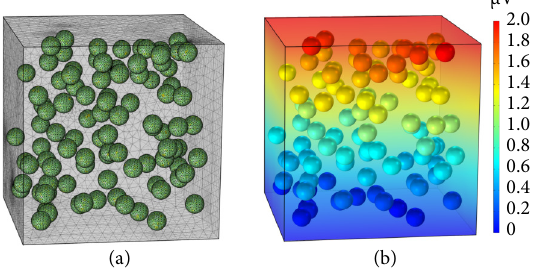
Fig. 3 The FEM to predict the relative permittivity of BT/PVDF composite. (a) Mesh configuration and (b) electric potential distribution within the mate-